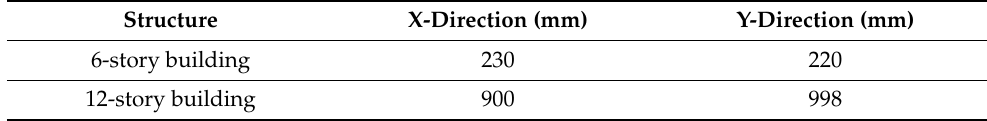
Table 6. Maximum displacement comparison from the time-history